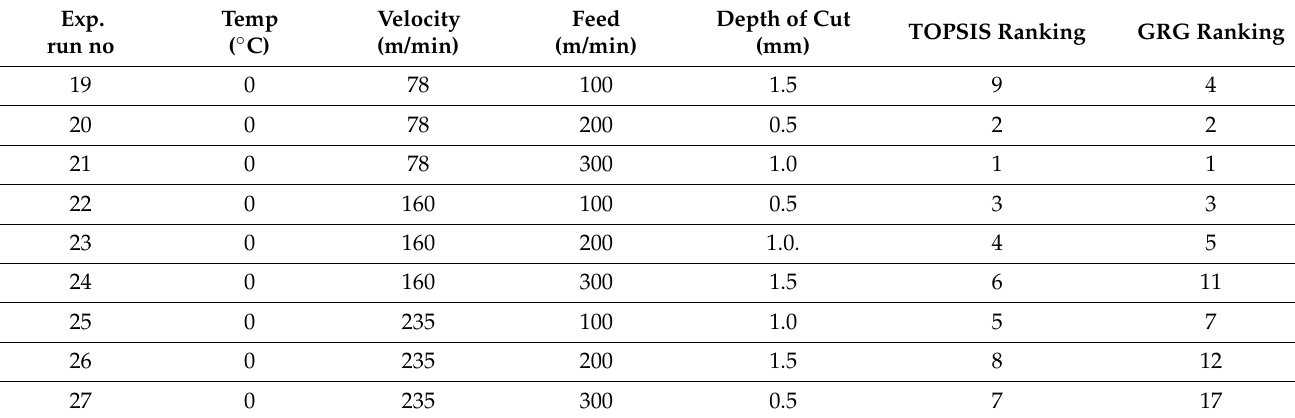
Table 9. Comparison of ranking by TOPSIS and GRG methods.